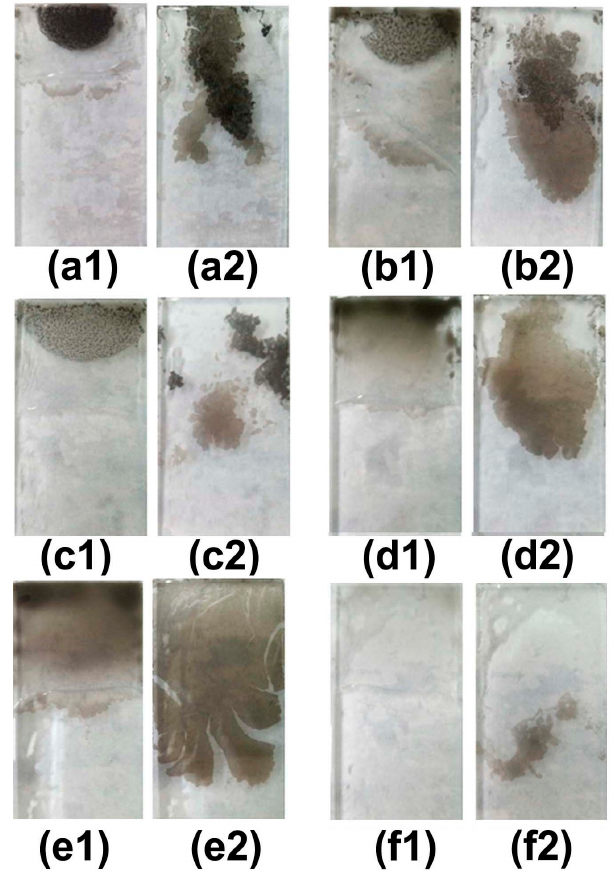
Figure 3. The different concentration of CS solution used to prepare CS films by interface self-assembly and transferred method: ( a1 , a2 ) 1%; ( b1 , b2 ) 0.5%; ( c1 , c2 ) 0.4%; ( d1 , d2 ) 0.3%, ( e1 , e2 ) 0.2%; and ( f1 , f2 ) 0.1% wt/mL, respectively.